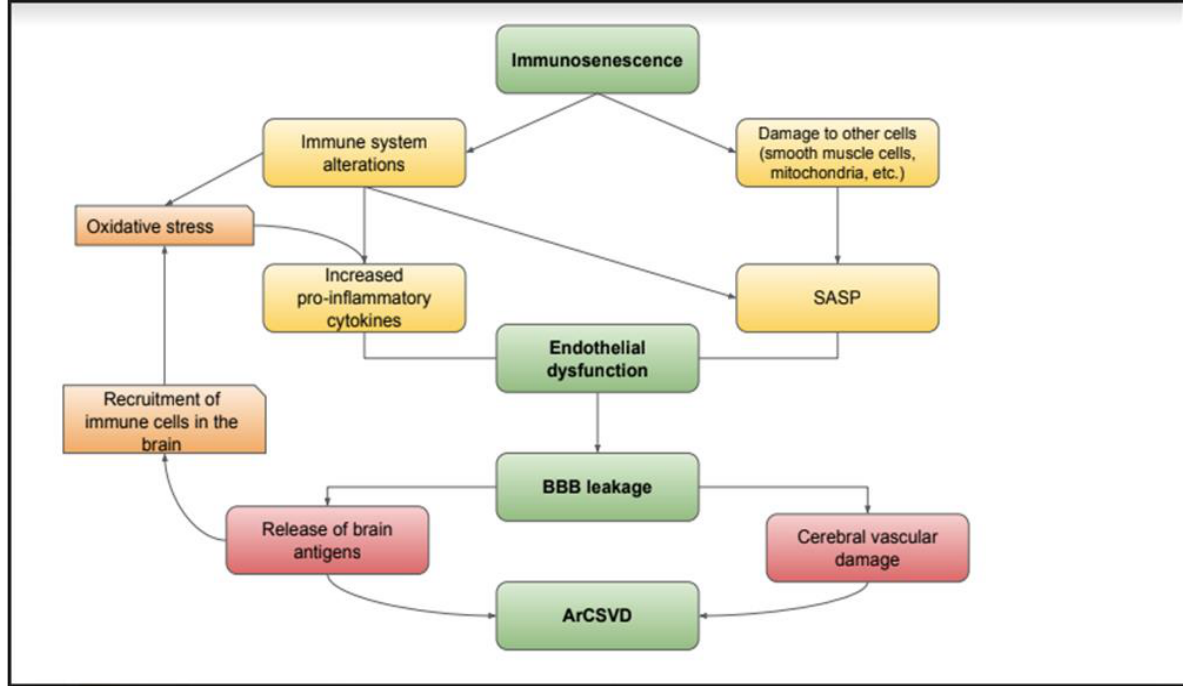
Figure 3. Aging causes alterations in the innate and adaptive immune system that lead to increased oxidative stress and endothelial dysfunction; this results in an alteration of the blood – brain barrier and a release of brain antigens into the systemic circulation, leading to a recall of immune cells in the brain. The amplification of the immune response feeds the inflammatory damage, establishing a self-feeding circuit that generates and worsens